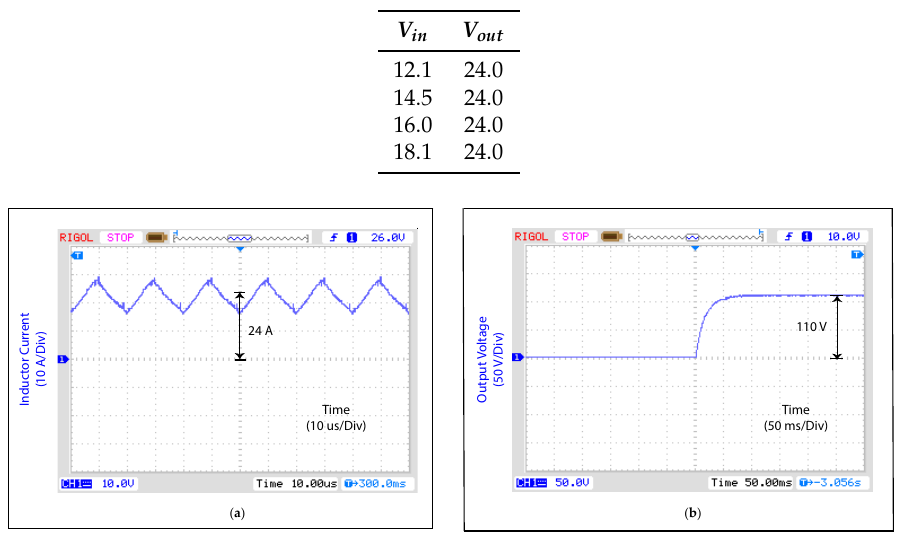
Table 2. Output voltages for variations in input.